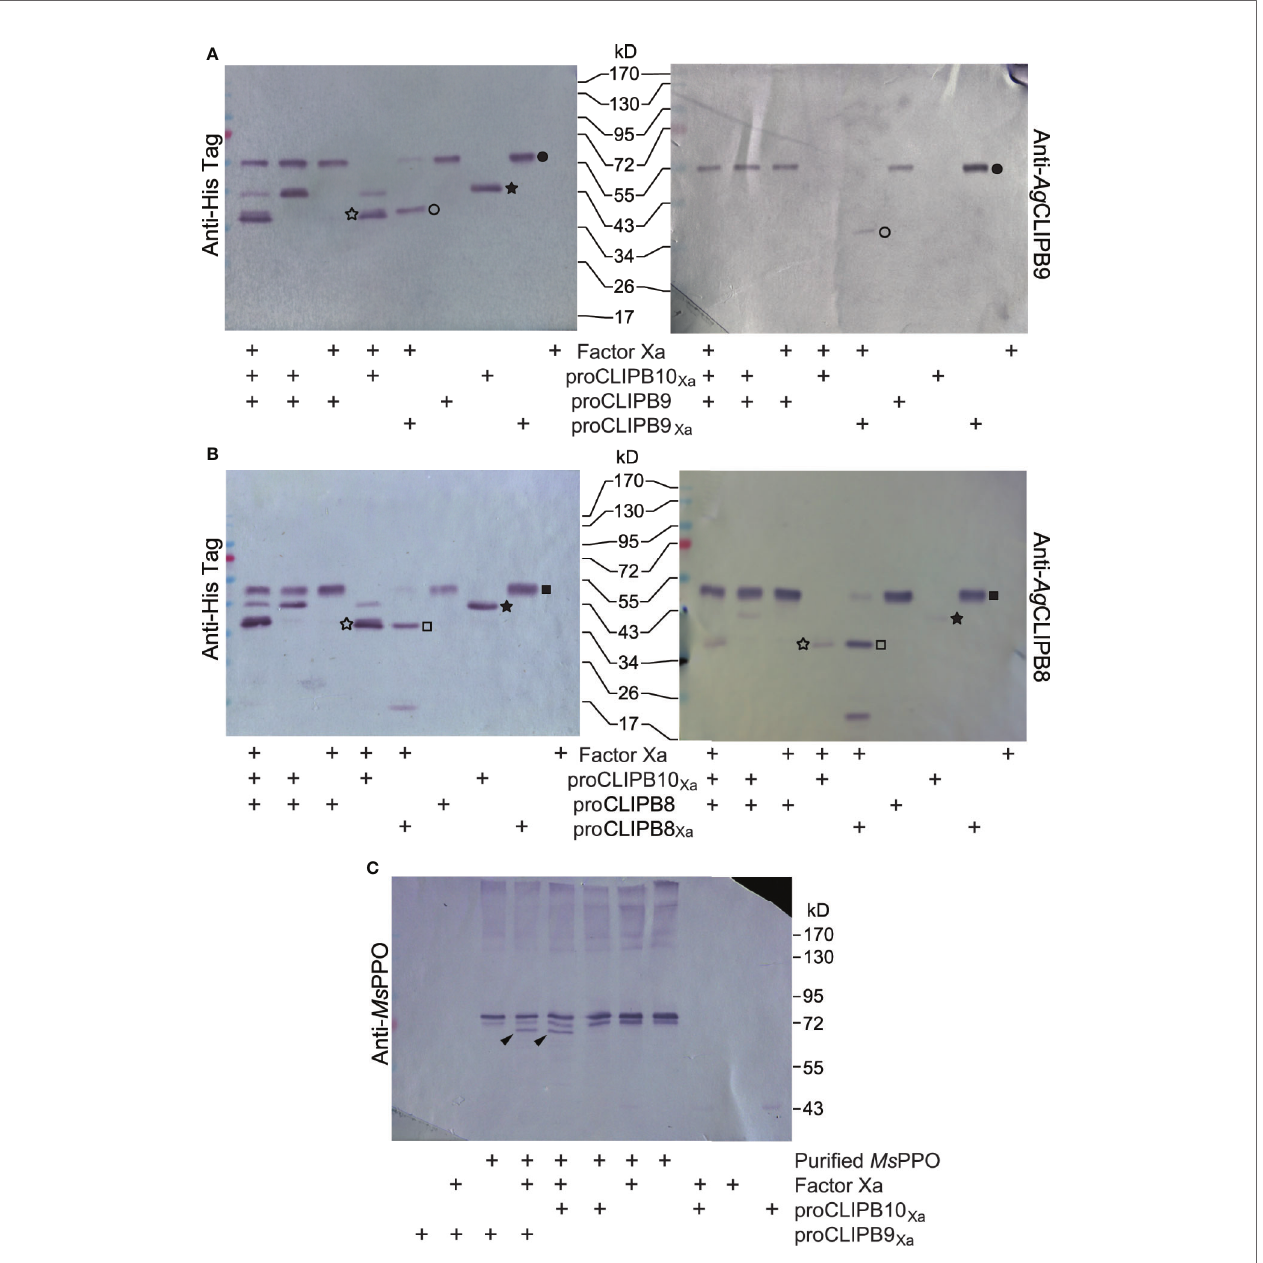
FIGURE 4 | Placement of CLIPB10 in the proPO activation cascade. (A) Neither activated rCLIPB10 Xa , nor commercial Factor Xa cleave recombinant wild-type proCLIPB9. (B) Neither activated rCLIPB10 Xa , nor commercial Factor Xa cleave recombinant wild-type proCLIPB8. All recombinant proteins contain a His-tag at their C-terminus, which is detected by anti-His antibody (left panels), and are also recognized by their speci fi c antibodies. Filled star, proCLIPB10 Xa ; open star, protease domain of rCLIPB10 Xa ; fi lled circle, zymogen form of the recombinant proCLIPB9 and proCLIPB9 Xa , open circle, protease domain of rCLIPB9 Xa ; fi lled square, zymogen form of the recombinant proCLIPB8 and proCLIPB8 Xa ; open square, protease domain of rCLIPB8 Xa . (C) Activated rCLIPB10 Xa directly cleaves M. sexta proPO. Black arrows indicate a smaller PO band on Western blots probed with anti- M. sexta PPO